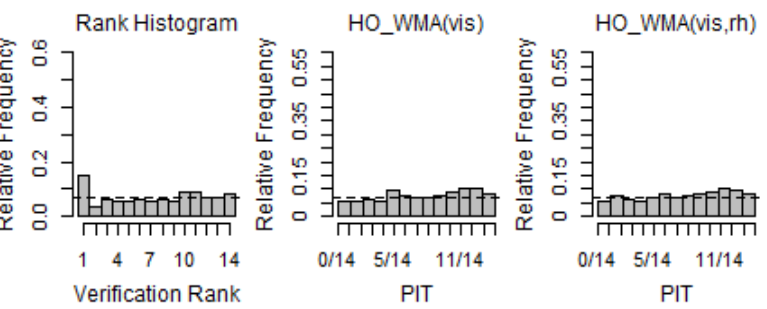
Figure 8. Verification rank histogram of raw ensemble forecasts and PIT histograms of WMA models for Station 113 (2019 MAM).